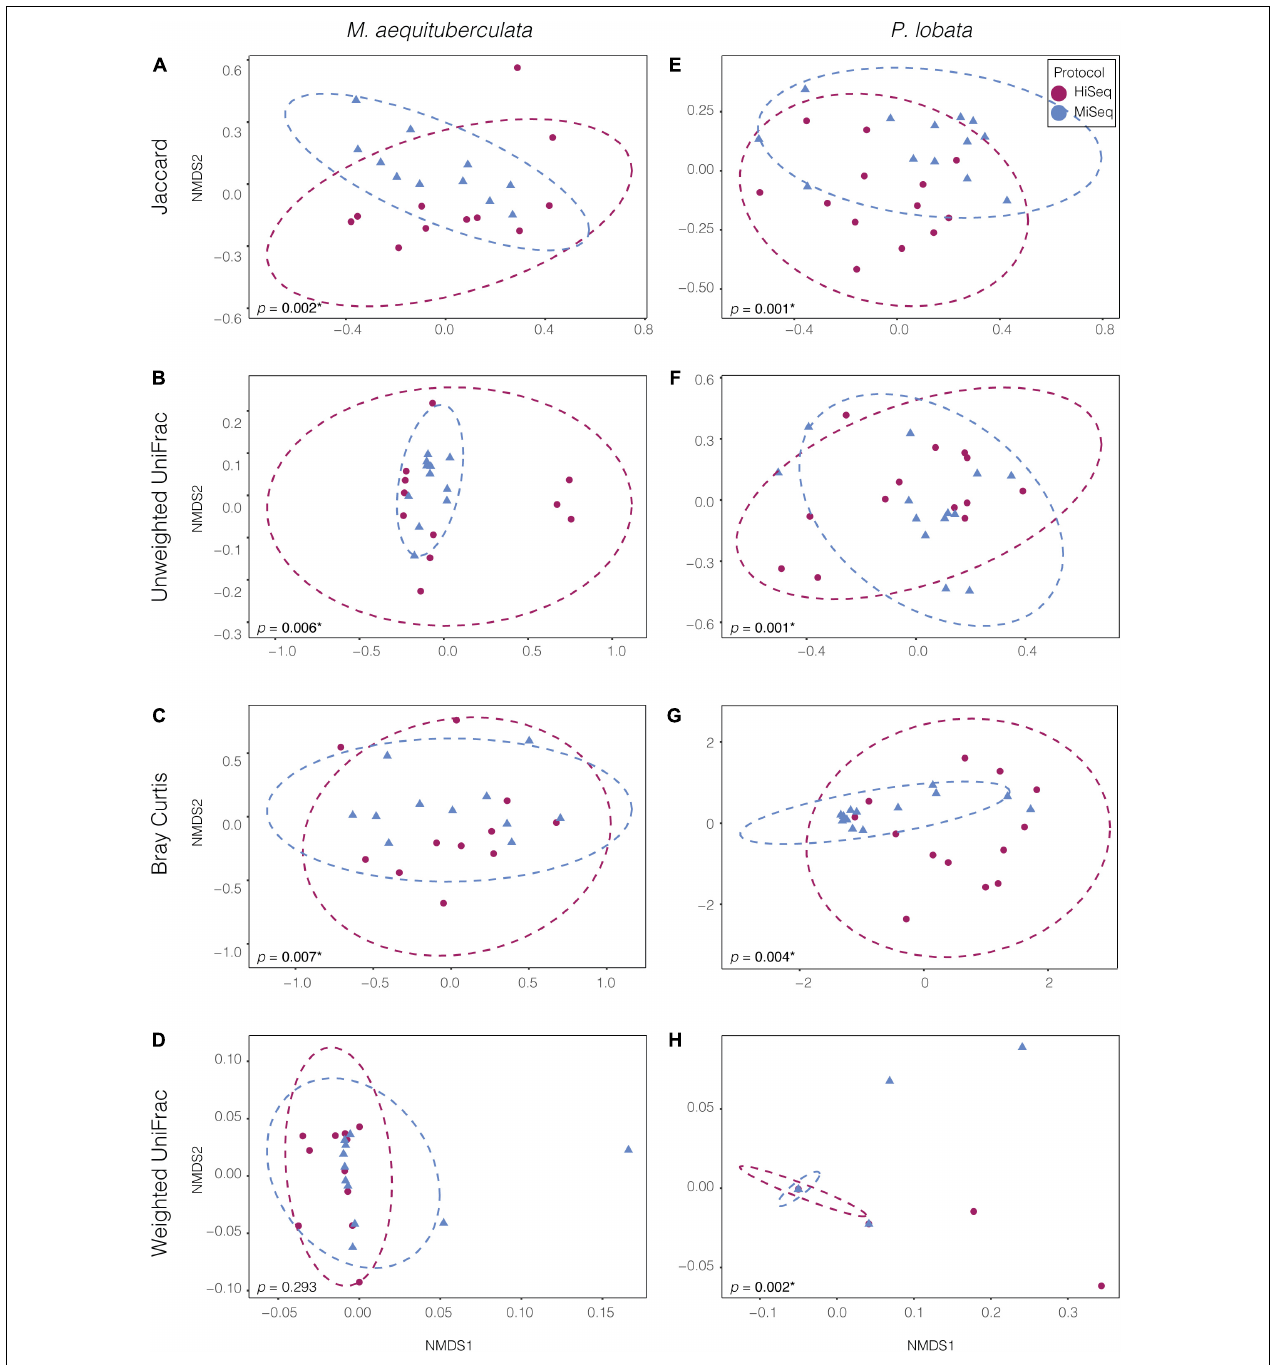
FIGURE 2 | Non-metric multidimensional scaling (NMDS) ordinations of ASV bacterial communities between the two species, M. aequituberculata (A–D) and P. lobata (E–H) for each of the four tested dissimilarity metrics: Jaccard, Unweighted UniFrac, Bray-Curtis and Weighted UniFrac. P-values with asterisks (*) refer to significant PERMANOVA results (see Supplementary Table 3